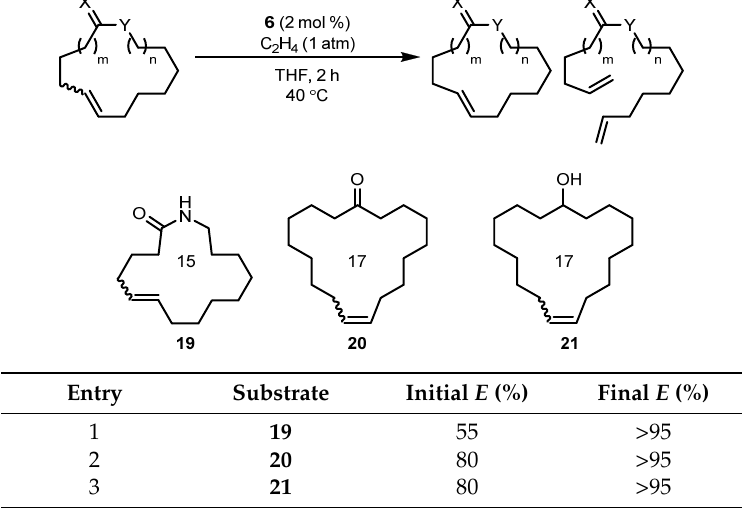
Table 6. Z -Selective ethenolysis of symmetric internal olefins providing E -isomer